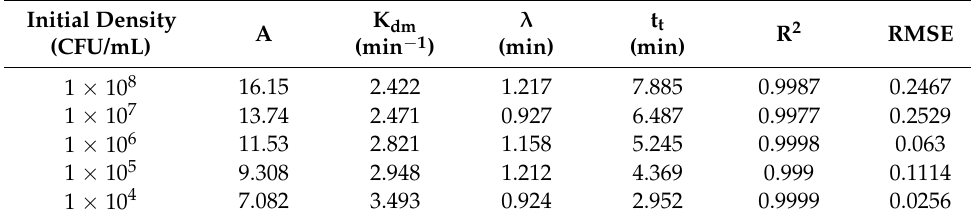
Figure 2. Effect of aPDT inactivating bacteria with 10 µ M curcumin for 21 min in different initial concentration. N 0 : initial cell counts; N: viable cell counts after treatment. Table 1. Estimation of the kinetic parameters of the modified Gompertz equation for the inactivation of S. aureus in PBS after aPDT.